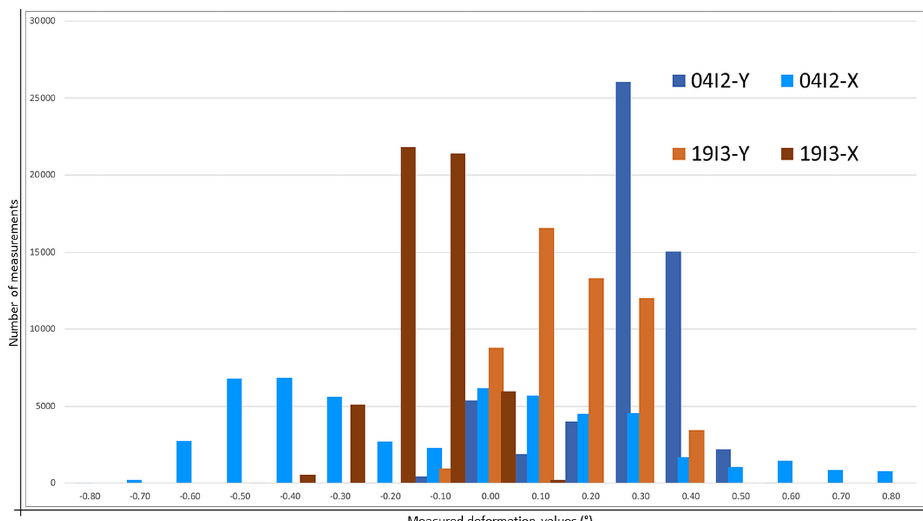
Figure 8. Data distribution of measurements of tiltmeters (04I2-X, 04I2-Y, 19I3-X and 19I3-Y).